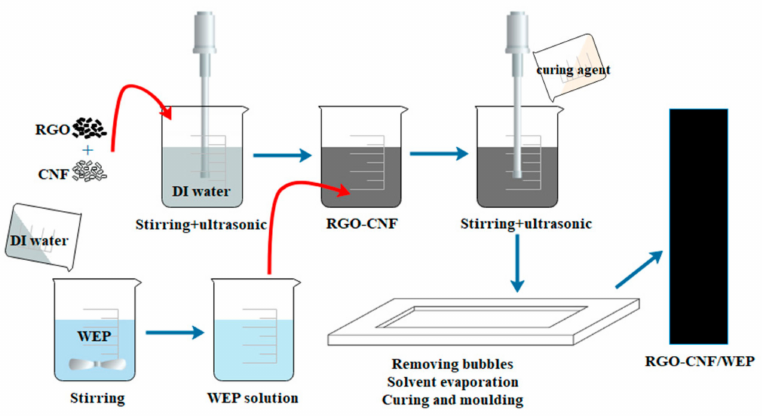
Figure 1. Fabrication process of the